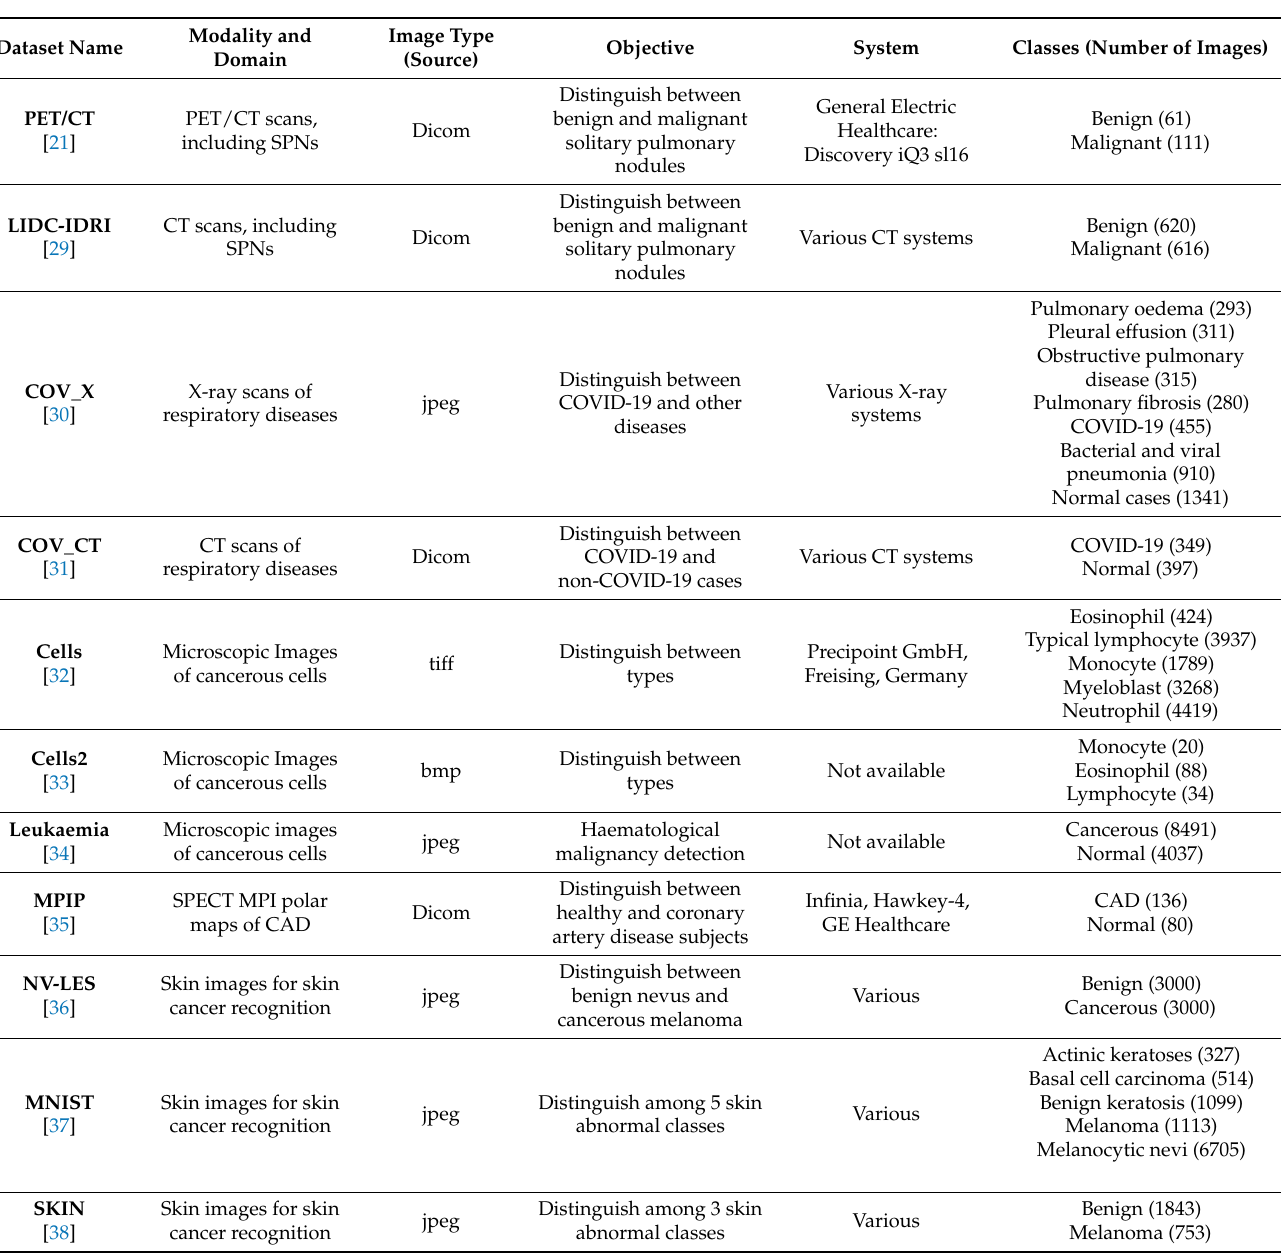
Table 1. Description of the study’s